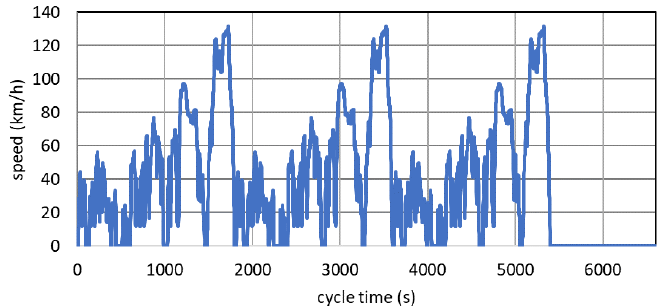
Figure 9. Vehicle speed in a repeated WLTP triple-mix drive cycle [12,61].